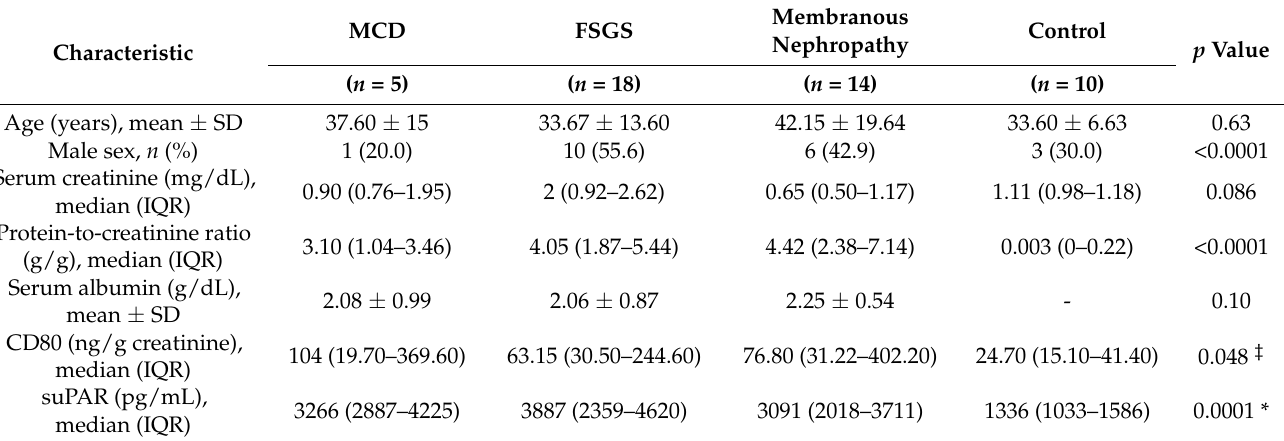
Table 1. Demographic characteristics and biomarker data at diagnosis in patients with glomeru- lopathies and in healthy